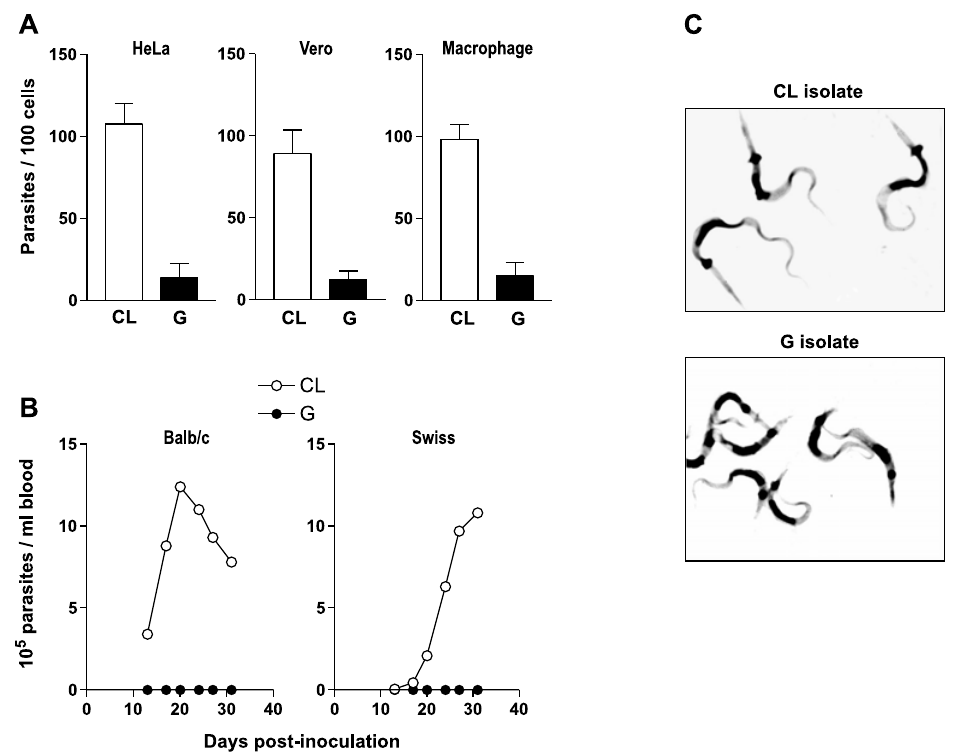
Fig. 2 – Differential in vitro and in vivo infectivity of T. cruzi isolates CL and G. A) MT infectivity upon incubation of parasites for 3h with different cell types (HeLa, Vero or mouse peritoneal macrophages). The values, expressed as the number of internalized parasites per 100 cells, correspond to the means ± SD of 10 (HeLa), 8 (Vero) or 5 (macrophage) experiments performed in duplicates, in which at least 500 Giemsa-stained cells were counted. B) Course of infection upon inoculation of 4 × 10 5 MT by oral route into Balb/c mice, or by intraperitoneal route into outbred Swiss mice. Each data point corresponds to the mean parasitemia of 6 animals. C) Purified MT of CL and G isolates stained with Giemsa. Note that MT of CL isolate are longer and the kinetoplast is located more distal to the posterior end, as compared to G